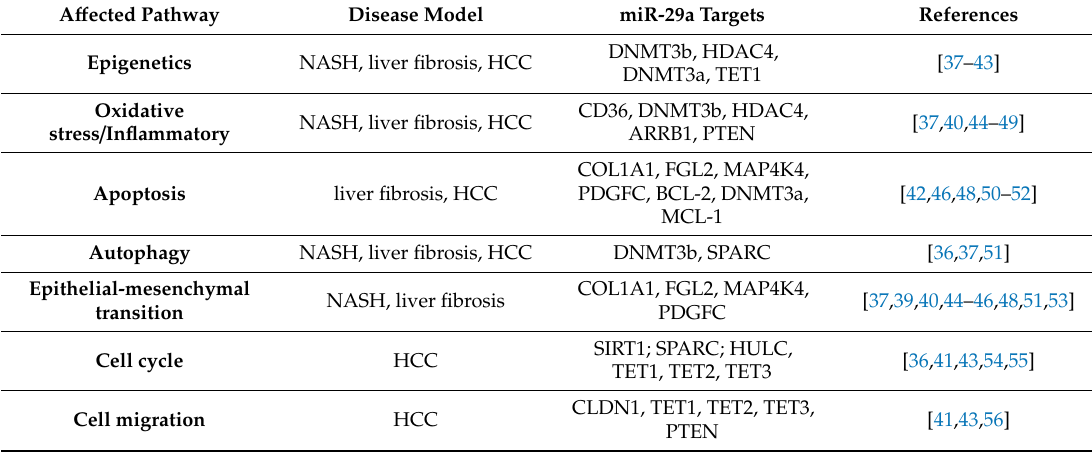
Table 1. Pleiotropic Role of miR-29a in in Liver